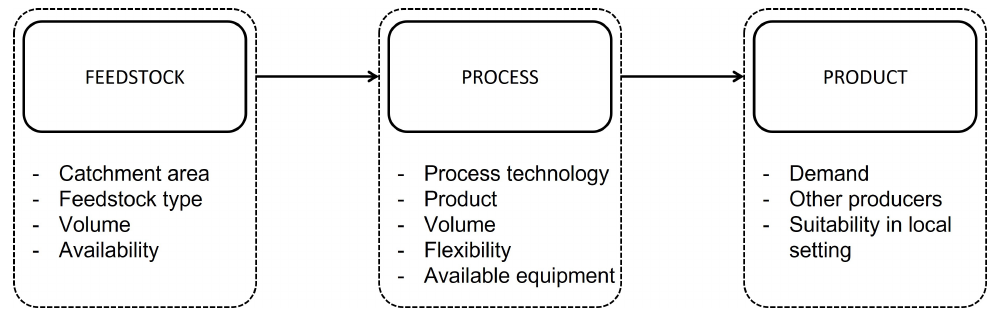
Figure 2. Simplified outline of a biorefinery with its three parts (feedstock, process and product), and their respective main strategic decisions (taken from